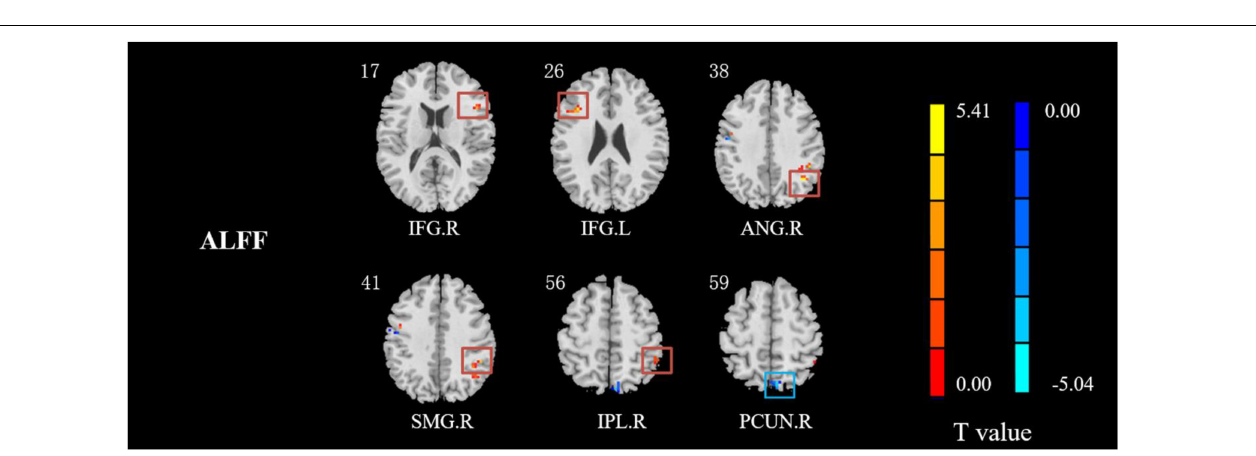
FIGURE 1 | Results of ALFF values of IXT patients (left) and HCs (right) in the rs-fMRI using one-sample t -test. ( P < 0.05, GRF correction).